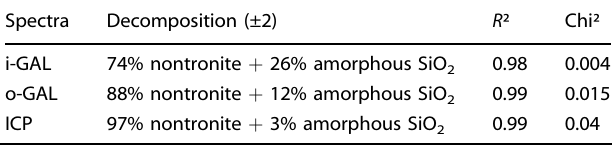
Table 3. Decomposition of the STXM spectra at Si K-edge obtained in i-GAL, in o-GAL (Fig. 5) and in ICP (Fig. 7f) containing silicon (right side, Fig. 2a).